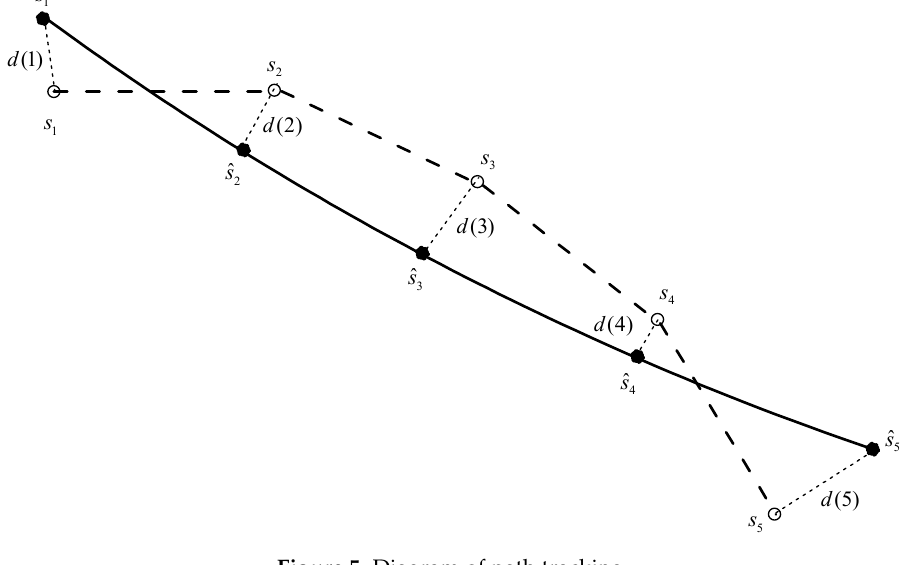
Figure 5. Diagram of path tracking.